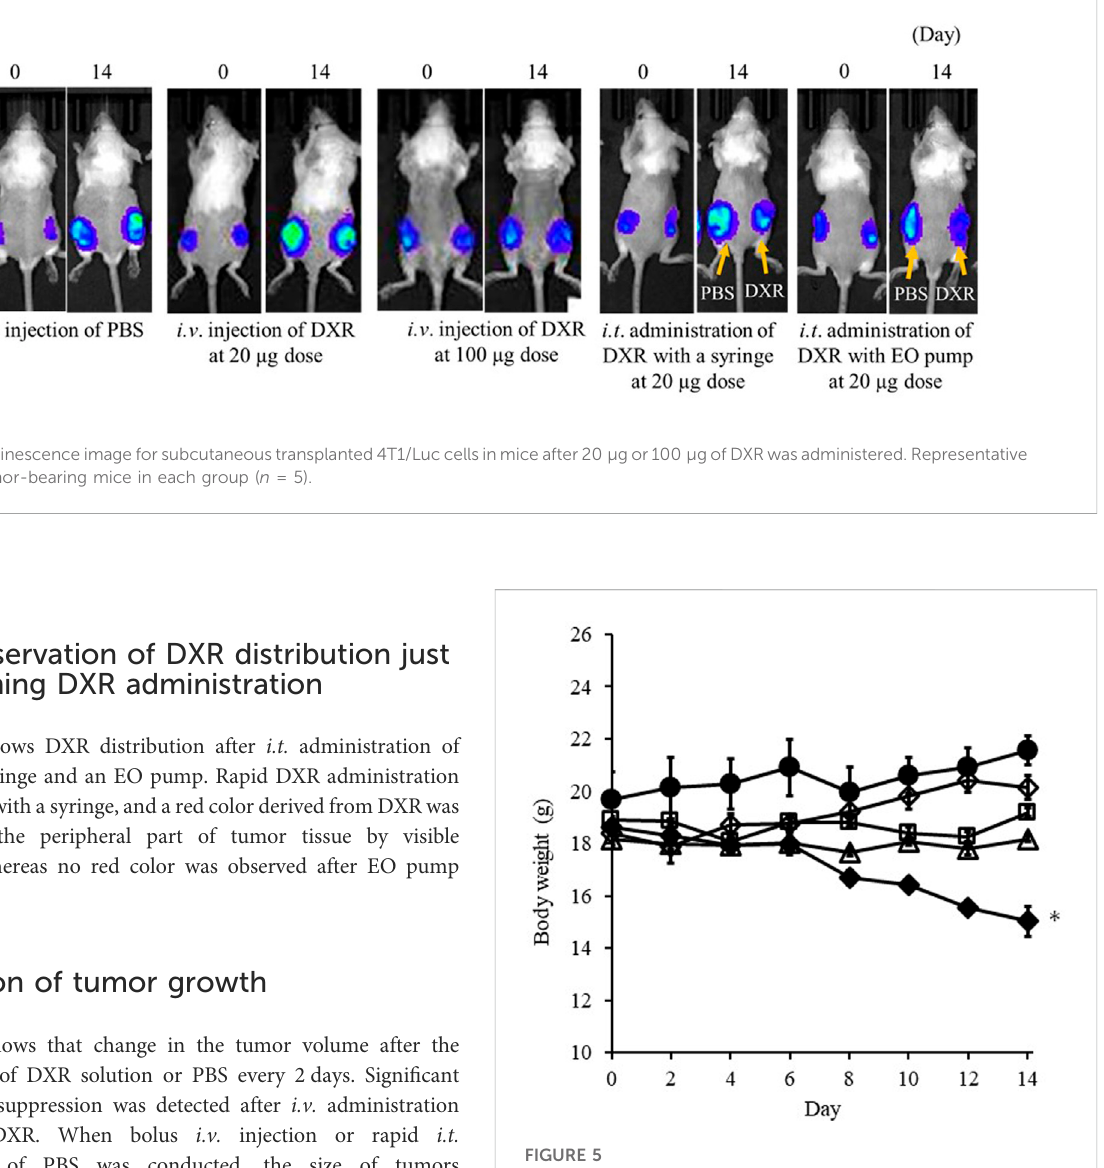
4 shows luciferase luminescence images of subcutaneously transplanted 4T1/Luc cells in mice after 20 µg or